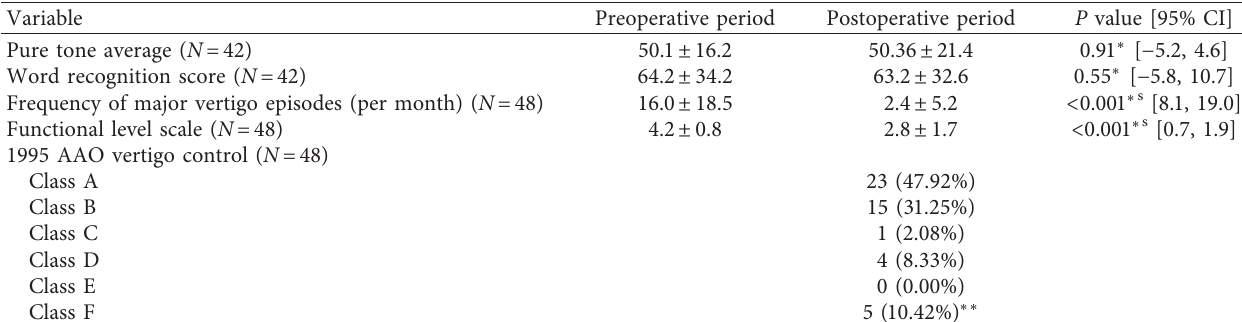
Table 2: Overall outcomes for endolymphatic sac surgery.